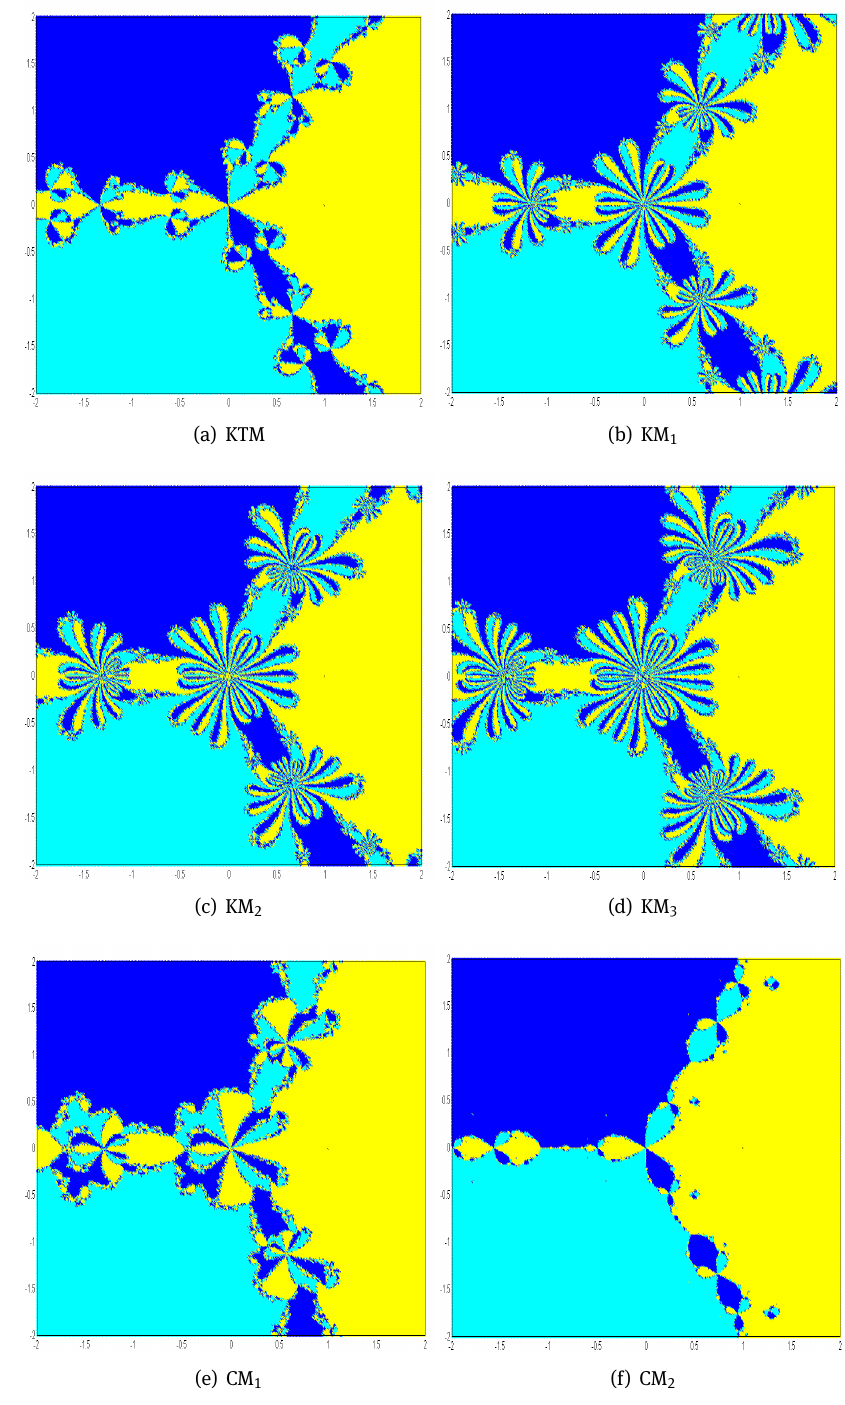
Figure 1: Basins of attraction of the methods KTM, KM 1 , KM 2 , KM 3 , CM 1 and CM 2 respectively for P 1 ( z ) = z 3 − 1